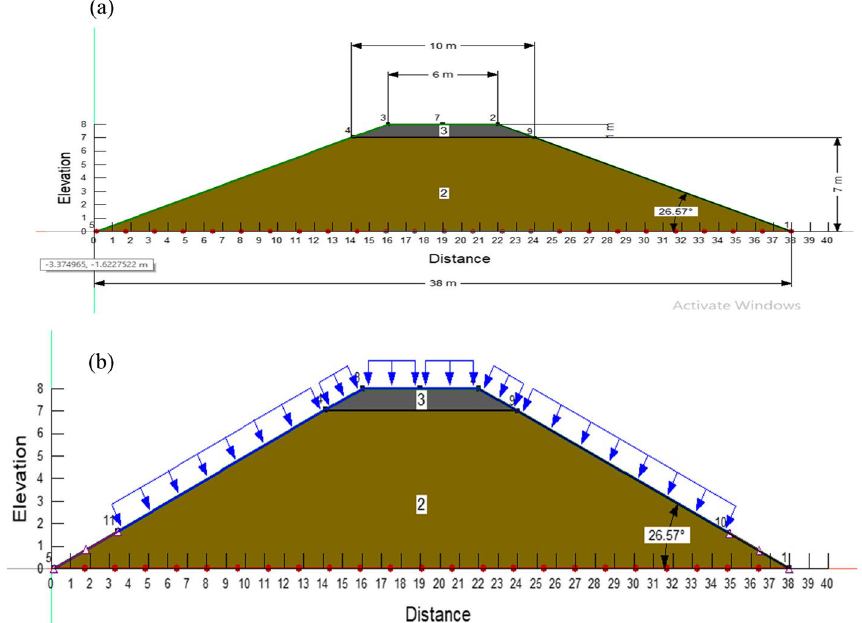
Fig. 20 a Dimensions of the Geo-Studio Model. b Boundary layers conditions of the model